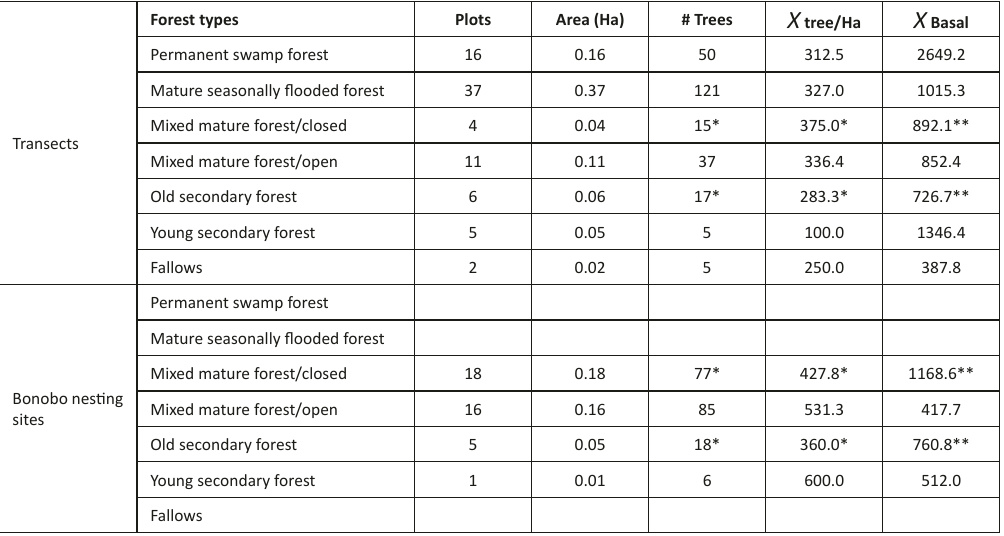
Table 2. Tree densities in non-nesting sites along transects and Bonobo nesting sites in LTSF